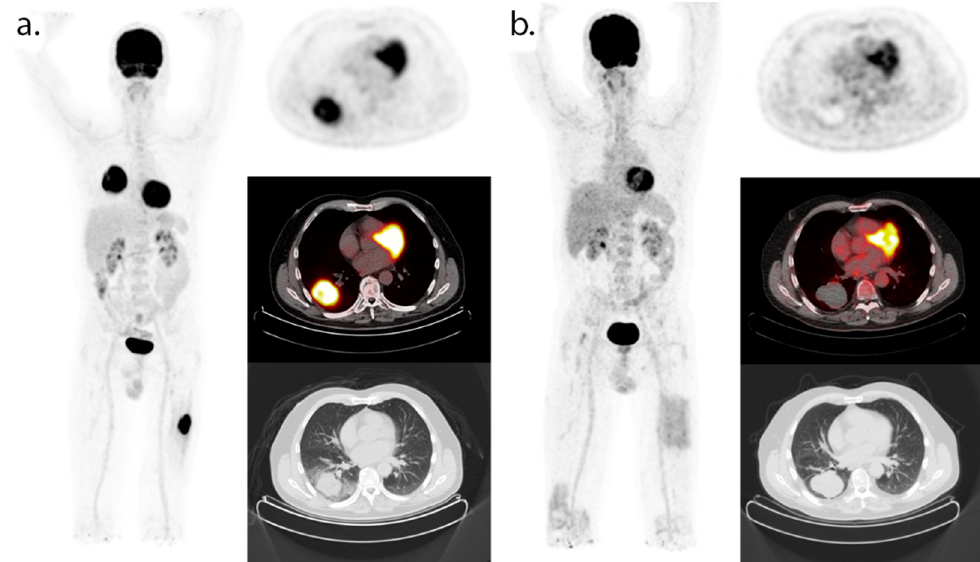
Figure 2. 18 F-FDG-PET/CT (maximum intensity projection and axial PET, fused PET/CT and CT images) at baseline ( a ) and during follow-up of immunotherapy ( b ). These images were obtained in our clinical institution as part of routine clinical follow-up. The patient provided verbal consent for the use of this anonymized imaging data. Baseline FDG-PET/CT prior to the start of nivolumab treatment showed a primary NSCLC tumor located in the right lower lobe and metastasis in the left femur. FDG-PET/CT after 13 months of nivolumab treatment showed a complete metabolic response. Due to toxicity, the patient has stopped nivolumab treatment in July 2017 and is still in remission.